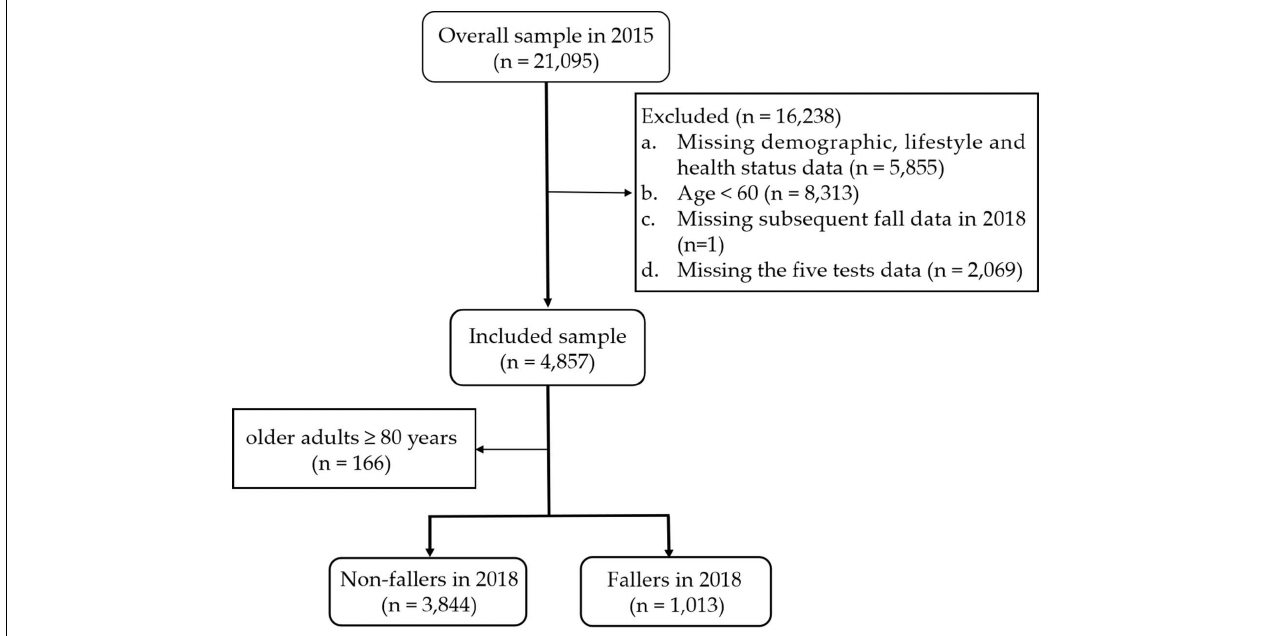
FIGURE 1 | Flow-chart showing the process of enrolling participants in the